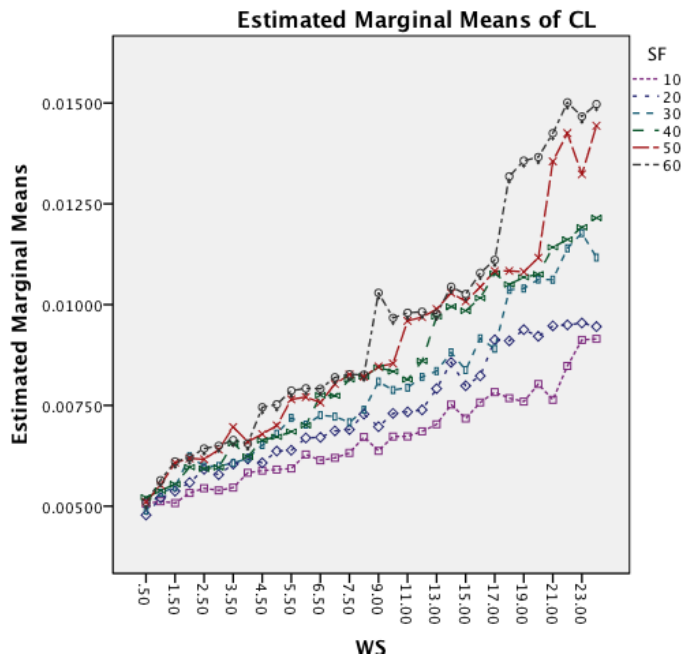
Figure 19. Two-way interaction effect for WS and SF.